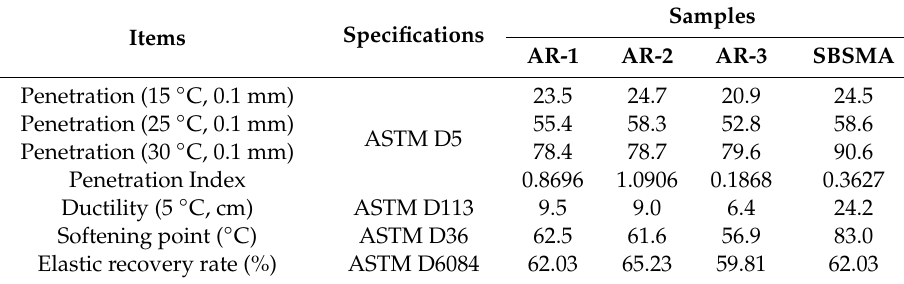
Table 4. Fundamental properties of AR and SBSMA binders.